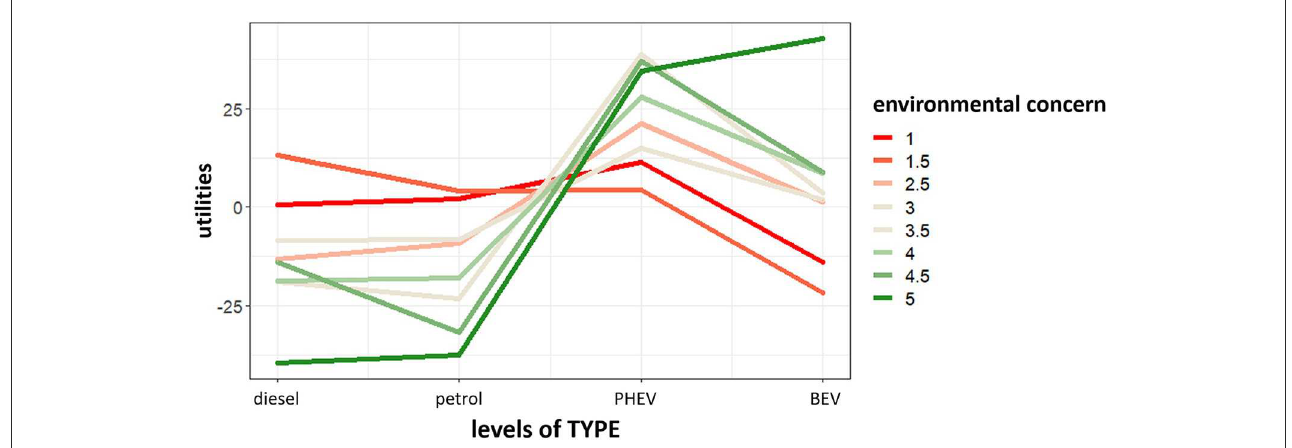
FIGURE3 Utility scores of the attribute engine type, among respondents with a lower and a higher environmental concern.